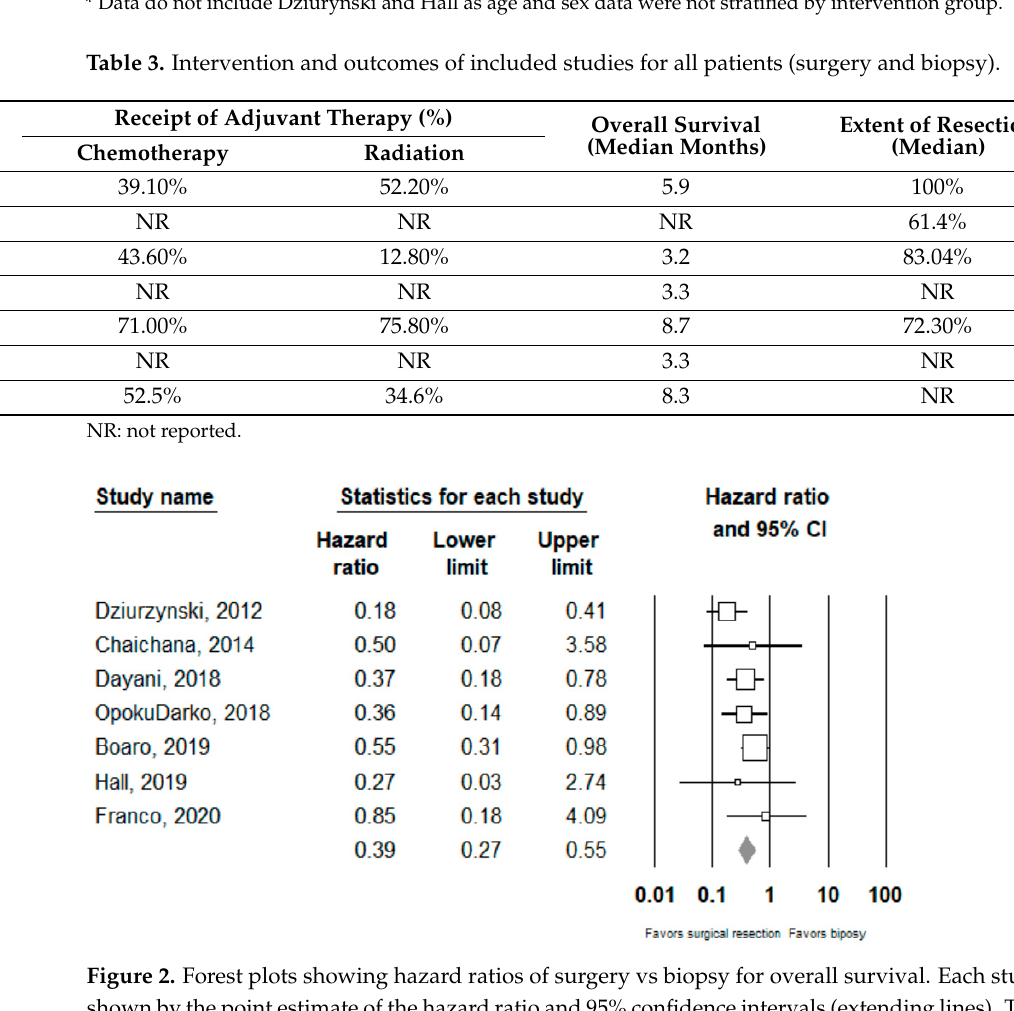
Table 3. Intervention and outcomes of included studies for all patients (surgery and biopsy).